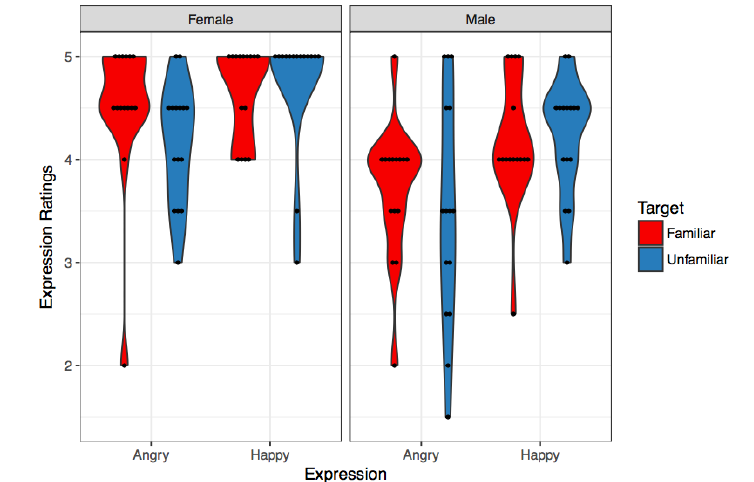
Figure 5. Ratings for recognizability of expression (1: not expressive, 5: very expressive) as a function of target expression. Left panel is for female targets, right panel is for male targets. Ratings were lower for male targets as compared to female targets and angry expression compared to happy expression. Error bars indicate 95% bootstrapped confidence intervals. Black dots represent responses from individual